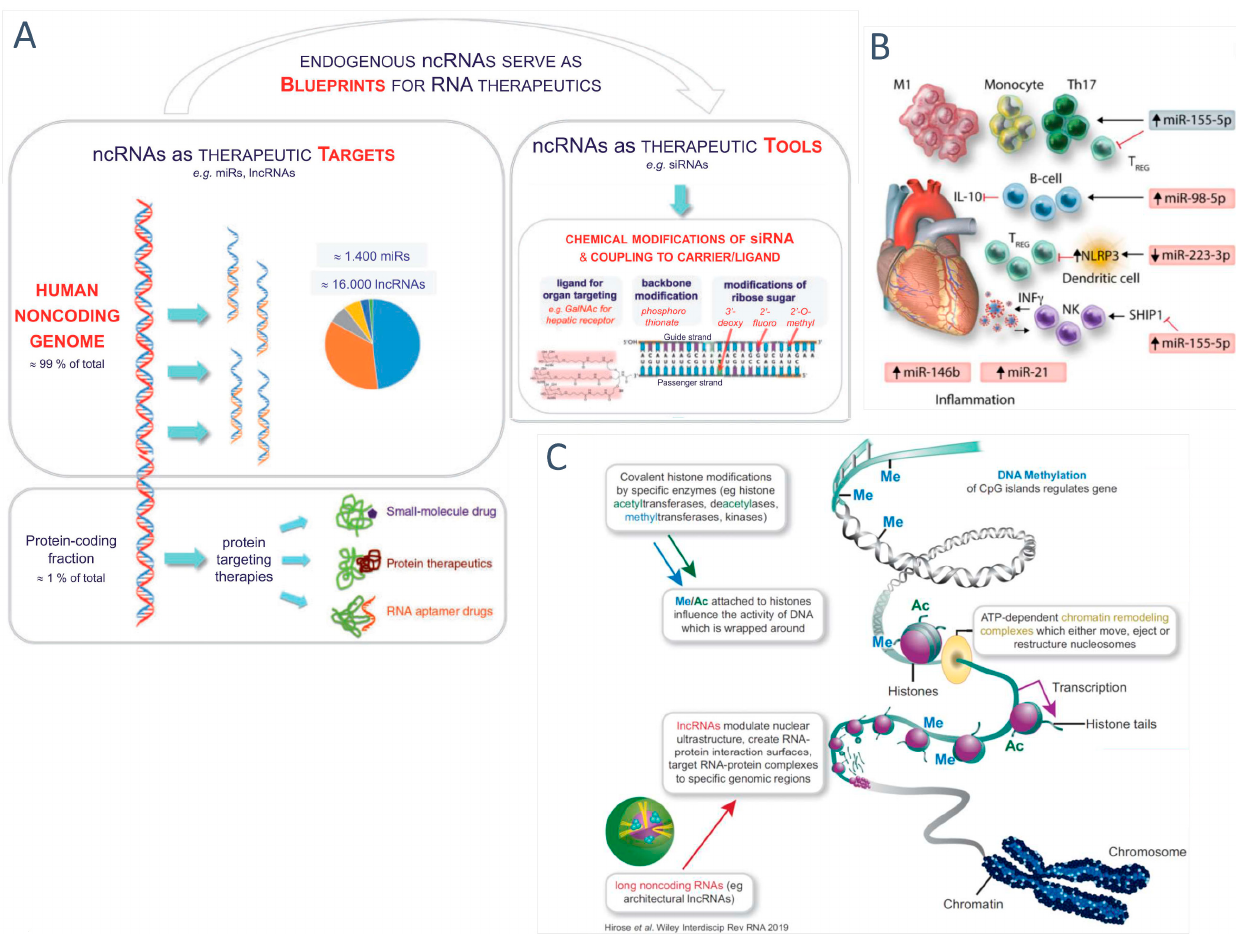
Figure 3. Key features of the human noncoding genome and epigenome, and novel therapeutic targets therein (modified from Poller et al. Eur. Heart. J. 2018 [1] and 2020 [2] by permission). ( A ) Noncoding RNAs are therapeutic targets and blueprints for therapeutic tools. ( B ) Inflammation- associated miR targets. ( C ) Epigenome structures and modifiers. Panel A : About 99% of the human genome does not encode proteins, but are transcriptionally highly active and give rise to a broad spectrum of ncRNAs with regulatory and structural functions. The observation of a steeply increasing fraction of noncoding RNAs (ncRNAs), in contrast to the modest increase in the number of protein-coding genes during evolution from simple organisms to humans, suggests a major role of ncRNAs in humans. ncRNAs, including microRNAs (miRs), small interference RNAs (siRNAs), or long noncoding RNAs (lncRNAs), are involved in the maintenance of cellular homeostasis and the innate immune response to tissue injury or infection. Panel B : While many questions regarding the overall impact of the noncoding genome upon human health and disease are still unanswered [63–65], available experimental and clinical evidence so far suggests a limited number of miRs (miR-17-92 cluster, miR-21, miR-142, miRNA-146a, miR-155, miR-181, and miR-223) [66] and lncRNAs [1,2,67] may constitute therapeutic targets in cardiovascular diseases. For each individual target, however, this depends on ensuring efficient drug targeting and clinical safety [68]. Panel C : Experimental studies [69] shed first light upon therapeutic targeting of the epigenome epigenetics in the context of heart failure. While epigenetic modification is a highly interesting field of research, it should be emphasized [2] that epigenetic modifications are likely to result in pleiotropic actions, making clinical translation particularly challenging (modified from [1,2] by permission of Eur. Heart